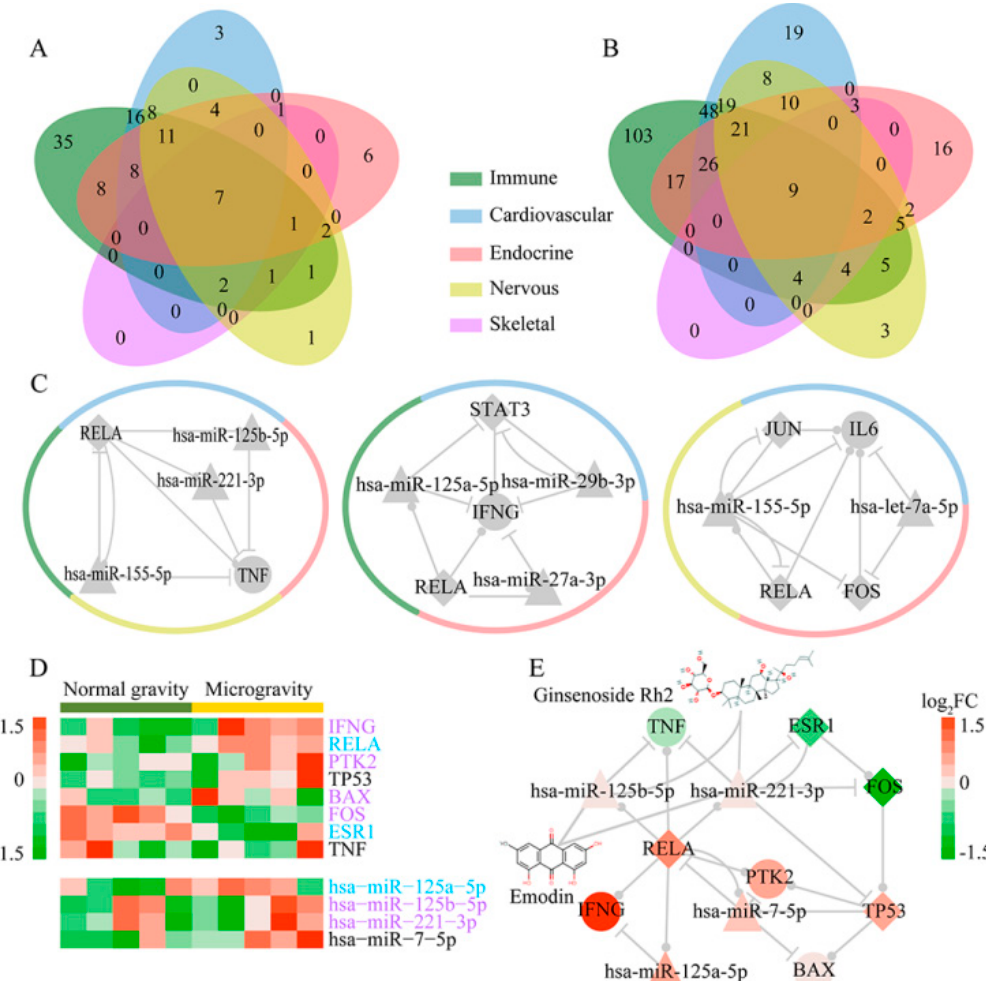
Figure 4. Five human body system subnetwork analysis and candidate drugs for bone loss. Venn diagram of nodes ( A ) and edges ( B ) in five subnetworks. ( C ). Modules shared by at least three subnetworks. The diamond, triangle and circular node represent TF, miRNA and gene, respectively. The colors of the circle outside the module represent corresponding systems. ( D ). Heatmap of genes and miRNAs in skeletal system subnetwork. Purple and blue text represent that the gene or miRNA functions are related to osteoblast and osteoclast, respectively. ( E ). Skeletal system subnetwork and the potential drugs reversing bone loss. Red and green represent upregulation and downregulation, respectively. The darker color represents larger |log 2 FC| value. The diamond, triangle and circular node represent TF, miRNA and gene, respectively.